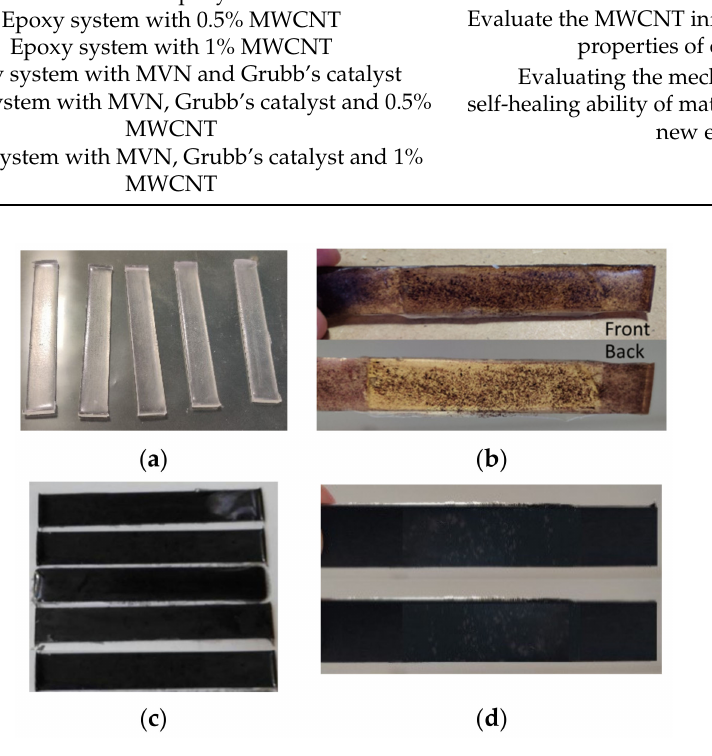
Figure 9. Images of ( a ) reference, ( b ) epoxy, microvascular network and Grubb’s catalyst, ( c ) epoxy and MWCNT and ( d ) epoxy, microvascular network, Grubb’s and MWCNT